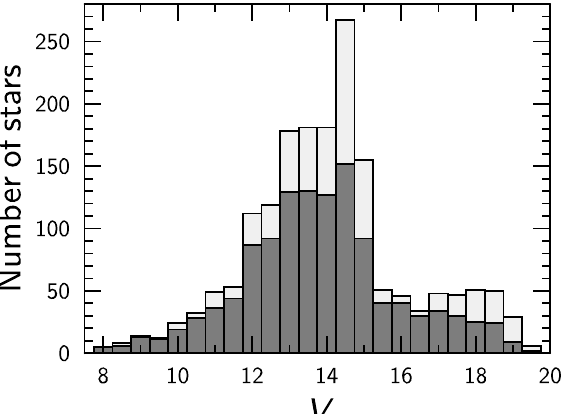
Fig. 3. Distribution of the measured stars in apparent magnitudes. The shaded parts of columns correspond to the stars for which two-dimensional spectral types (spectral and luminosity classes) are determined.